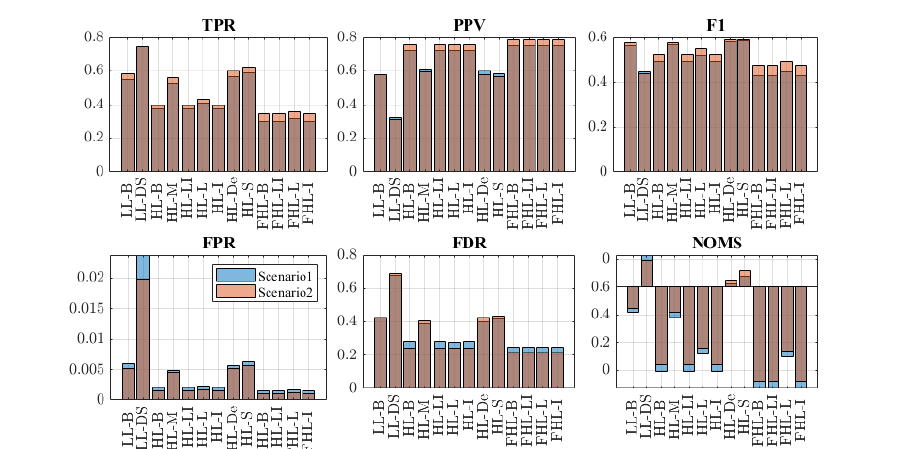
Figure 11. Colored bar plots of KPI results per scenario. TPR—True Positive Rate, PPV—Positive Predicted Value, F1 Score, FPR—False Positive Rate, FDR—False Detection Rate, NOMS—Normalized Occupancy Map